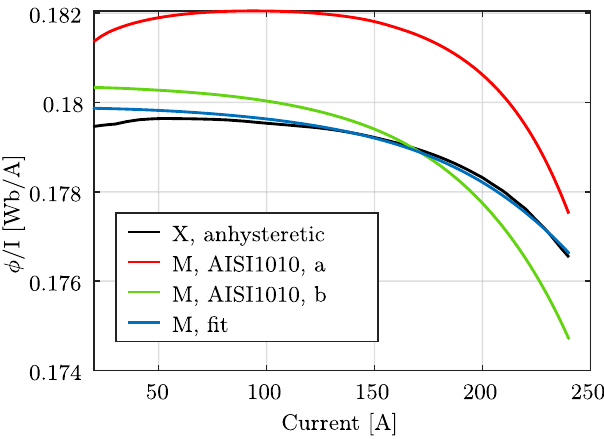
FIG. 4. Parameter fitting for the Wlodarski iron magnetization curve [Eq. (6)]. Excitation coil flux is reported for measurements and for the different stages of fitting.